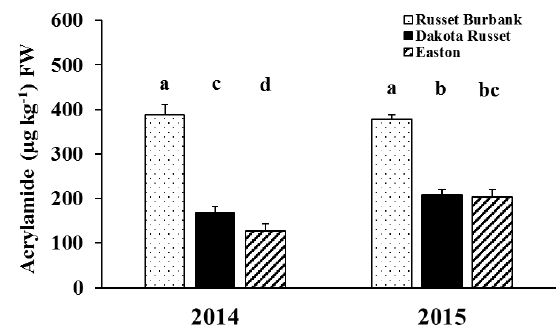
Figure 5. Cultivar by year interaction effect on acrylamide concentration at 16-week storage (Means were separated at the 5% level, with the same letter above the bar indicating no significant difference.).